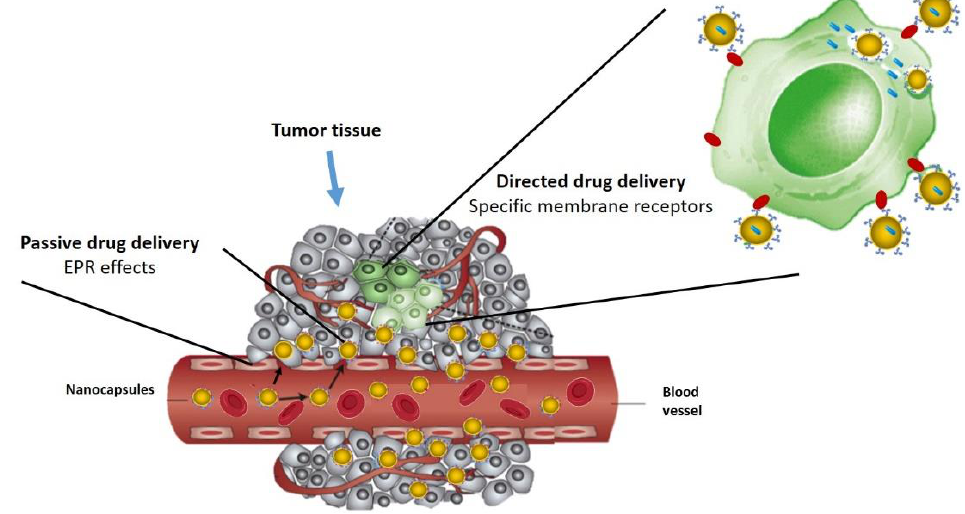
Figure 4. Graphical illustration of passive and active drug targeting. In passive targeting, the nanocarriers pass through the leaky walls and accumulate at the tumour site by the enhanced permeability and retention (EPR) effect. Active targeting can be achieved using specific ligands that bind to the receptors on the tumour cells.